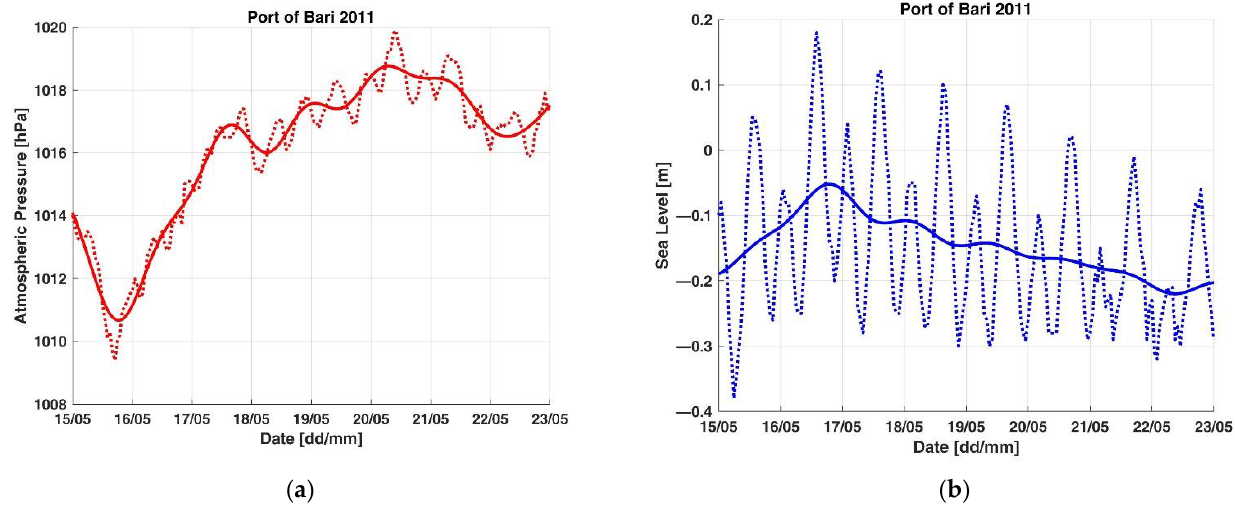
Figure 13. Low-frequency components of meteo- mareographic parameters acquired by ISPRA’s monitoring station in the port of Bari from 15 to 23 May 2011: ( a ) atmospheric pressure; ( b ) sea level; solid lines: low-frequency components surviv- ing the filtering; dashed lines: high-frequency components eliminated by the filtering.